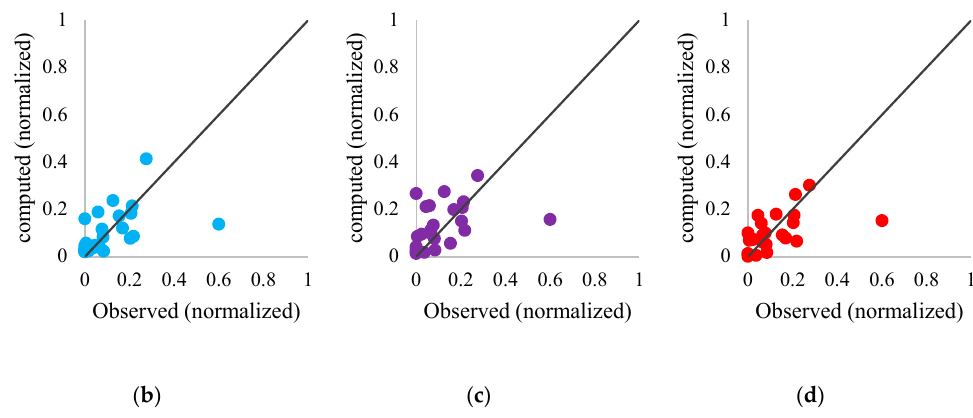
Figure 11. ( a ) Observed versus computed precipitation time series by FFNN, ANFIS and LSSVM models. Scatter plots for verification step for ( b ) FFNN; ( c ) ANFIS; ( d ) LSSVM models via scenario 2 for Girne station.